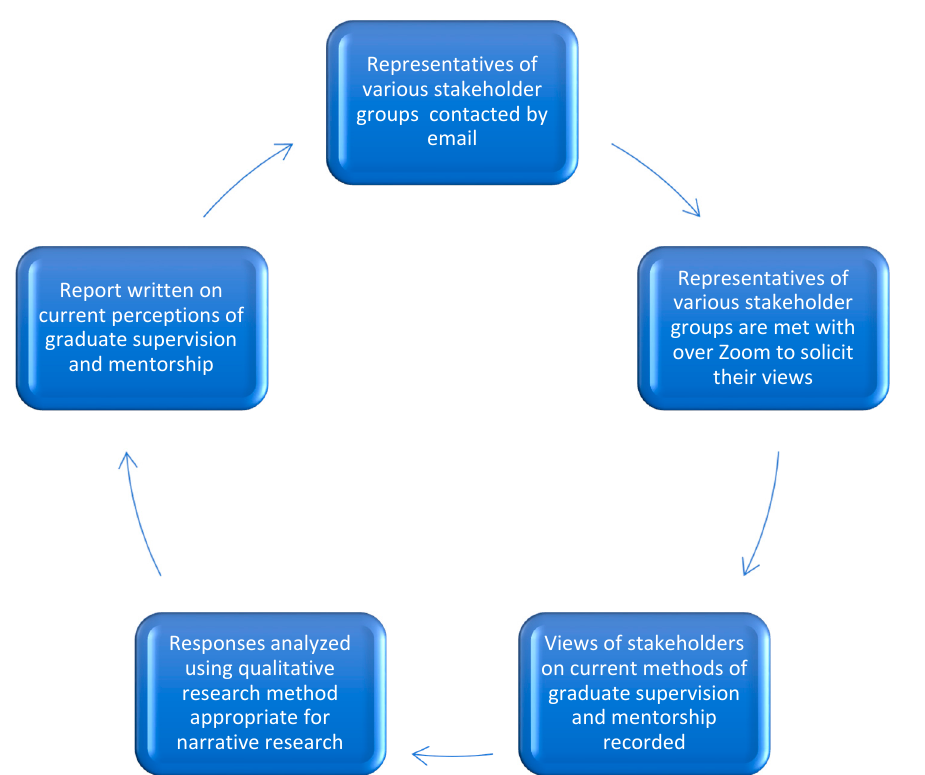
Figure 2. Process facilitator follows during Phase I of developing and presenting a report on current views of various stakeholder groups regarding graduate supervision and mentorship at a university. Depending on the responses given, the process may need to be repeated.